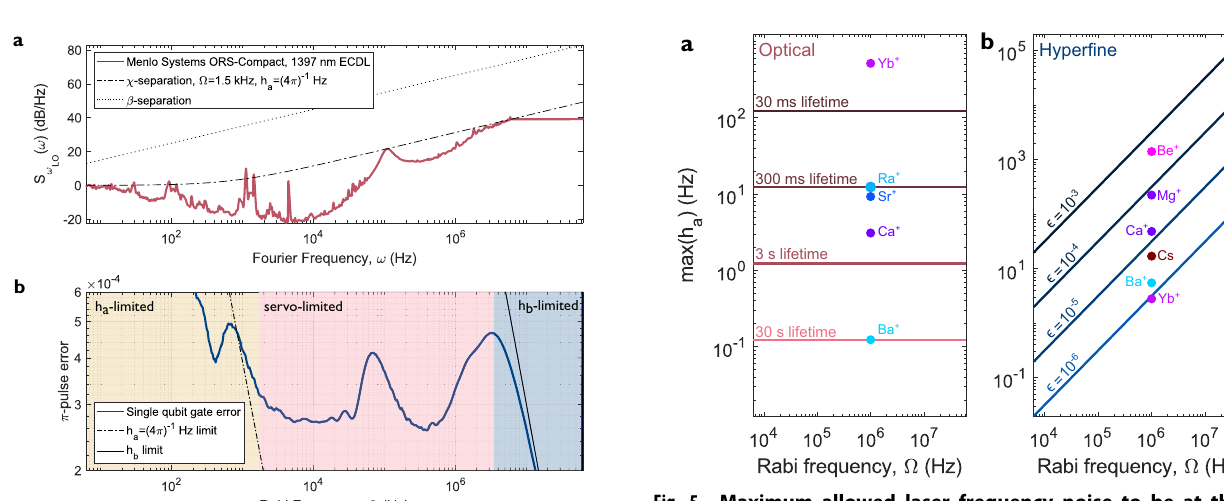
Fig. 5 Maximum allowed laser frequency noise to be at the SE fl oor in the in fi nite servo bandwidth limit for a primitive operation. In this limit the linewidth of the LO is approximately equivalent to Γ FWHM = h a /4 π . a Optical qubits, where the SE fl oor is given by the lifetime of the qubit state. Typical lifetimes of metastable atomic states are used, which approximately correspond to SE errors, ϵ SE , of 6 × 10 − 6 , 6 × 10 − 5 , 6 × 10 − 5 , and 6 × 10 − 3 , from longest to shortest respectively. The SE fl oors of S 1/2 → D 5/2 transitions in a selection of optical qubit candidates are shown for reference 16,52 . b Hyper fi ne qubits, where the SE fl oor is given by off- resonant scattering. We de fi ne ϵ ¼ 1 (cid:2) F . The requirement on laser noise is relaxed for higher Rabi frequency as less noise is sampled by the qubit and the SE error is constant with Rabi frequency. The value of h a corresponding to the minimum value of ϵ SE for a selection of hyper fi ne trapped ion and neutral atom qubit candidates at Ω = 1MHz are shown for